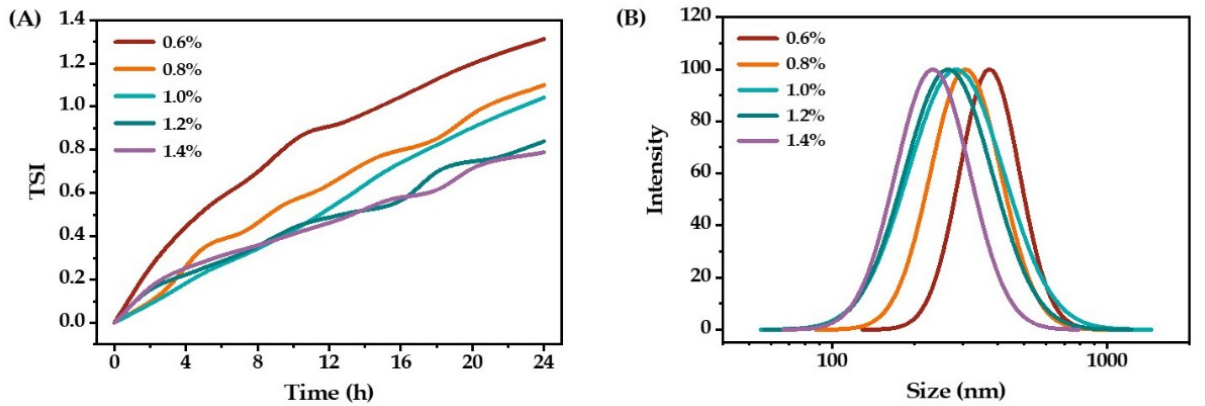
Figure 2. The stability ( A ) and droplet size distribution ( B ) of O/W emulsions prepared with different concentrations of triglycerol monolaurate.